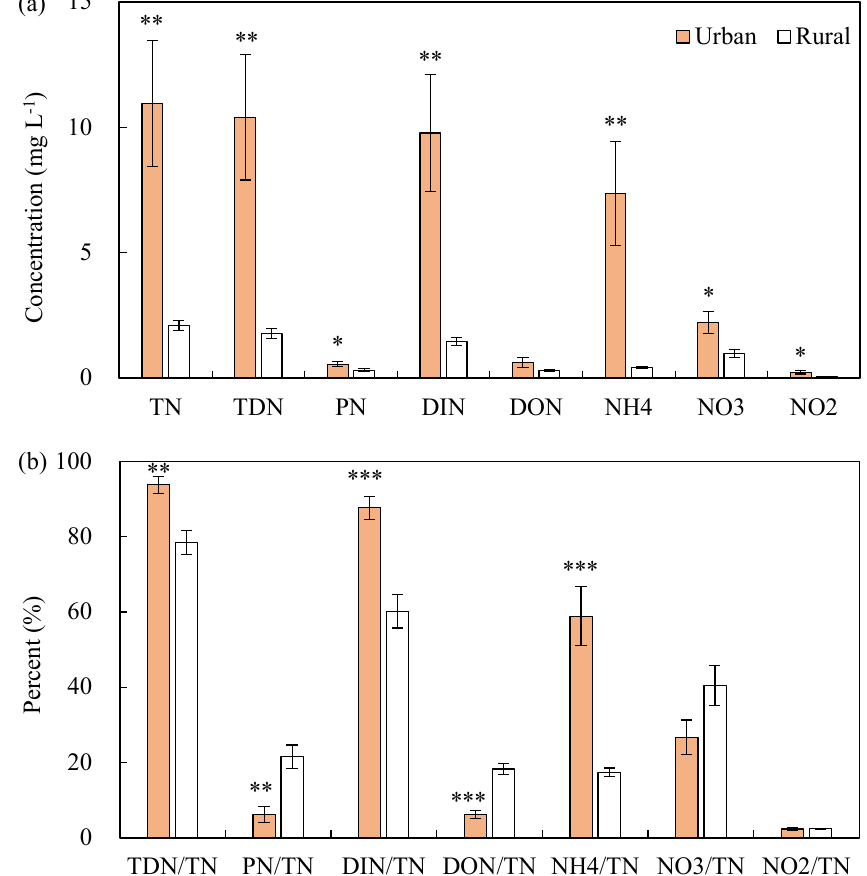
Figure 4. Concentrations of TN, TDN, PN, DIN, DON, NH 4 , NO 3 , and NO 2 ( a ); and percentages of TDN/TN, PN/TN, DIN/TN, DON/TN, NH 4 /TN, NO 3 /TN, and NO 2 /TN ( b